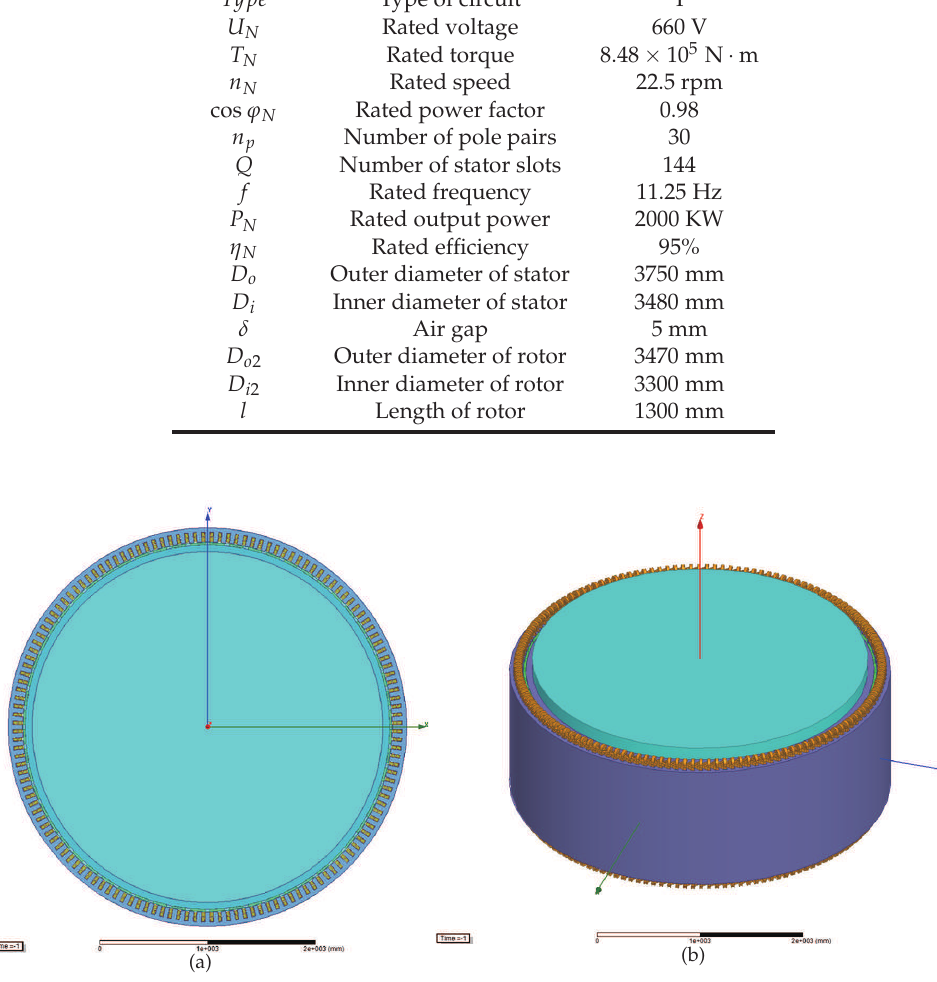
Figure 2. 2 MW D-SPMSG design model: ( a ) 2D-model of D-SPMSG; ( b ) 3D-model of